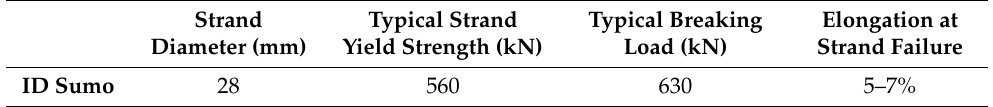
Table 3. ID SUMO bolt material properties.